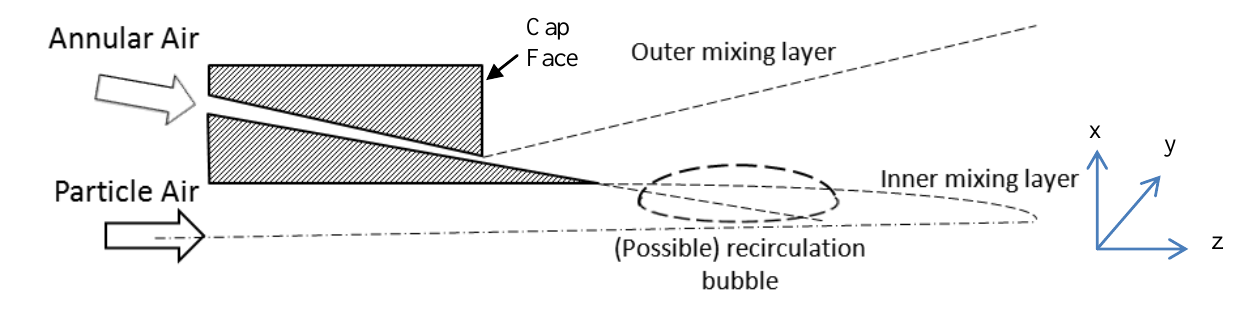
Table 1. Critical dimensions of the gun head.